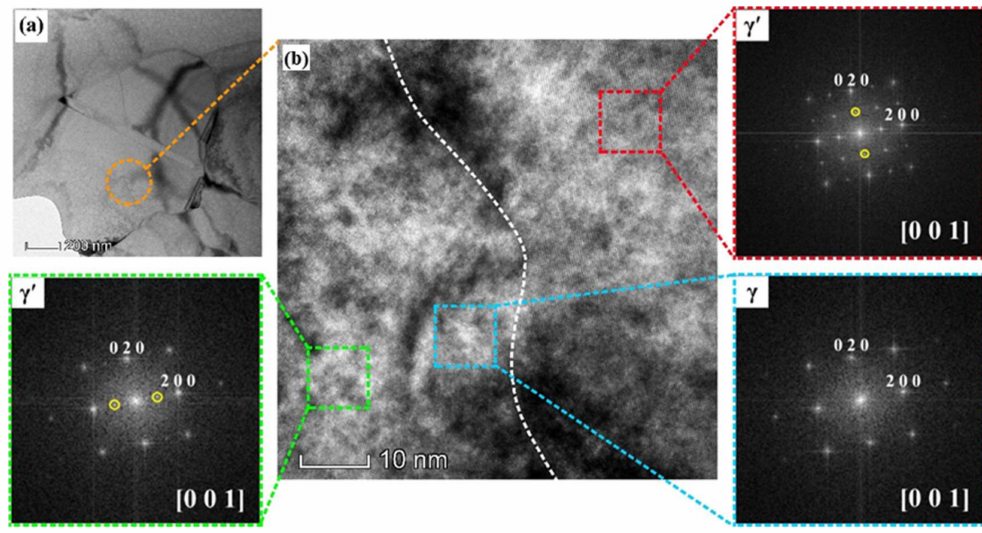
Figure 12. High-resolution TEM at the interface of coherent γ and γ ’ phase with corresponding di ff raction patterns simulated by fast Fourier transformations: ( a ) HRTEM of the DRX grain; ( b ) HRTEM of the interface